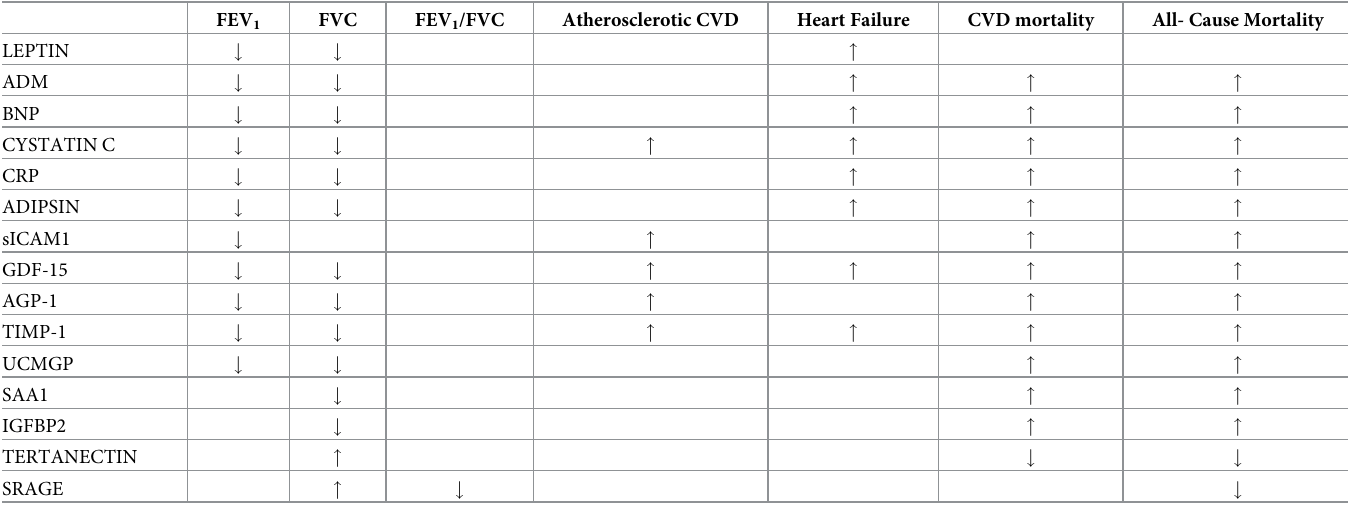
Table 5. Proteins associated with baseline lung function and cardiovascular disease